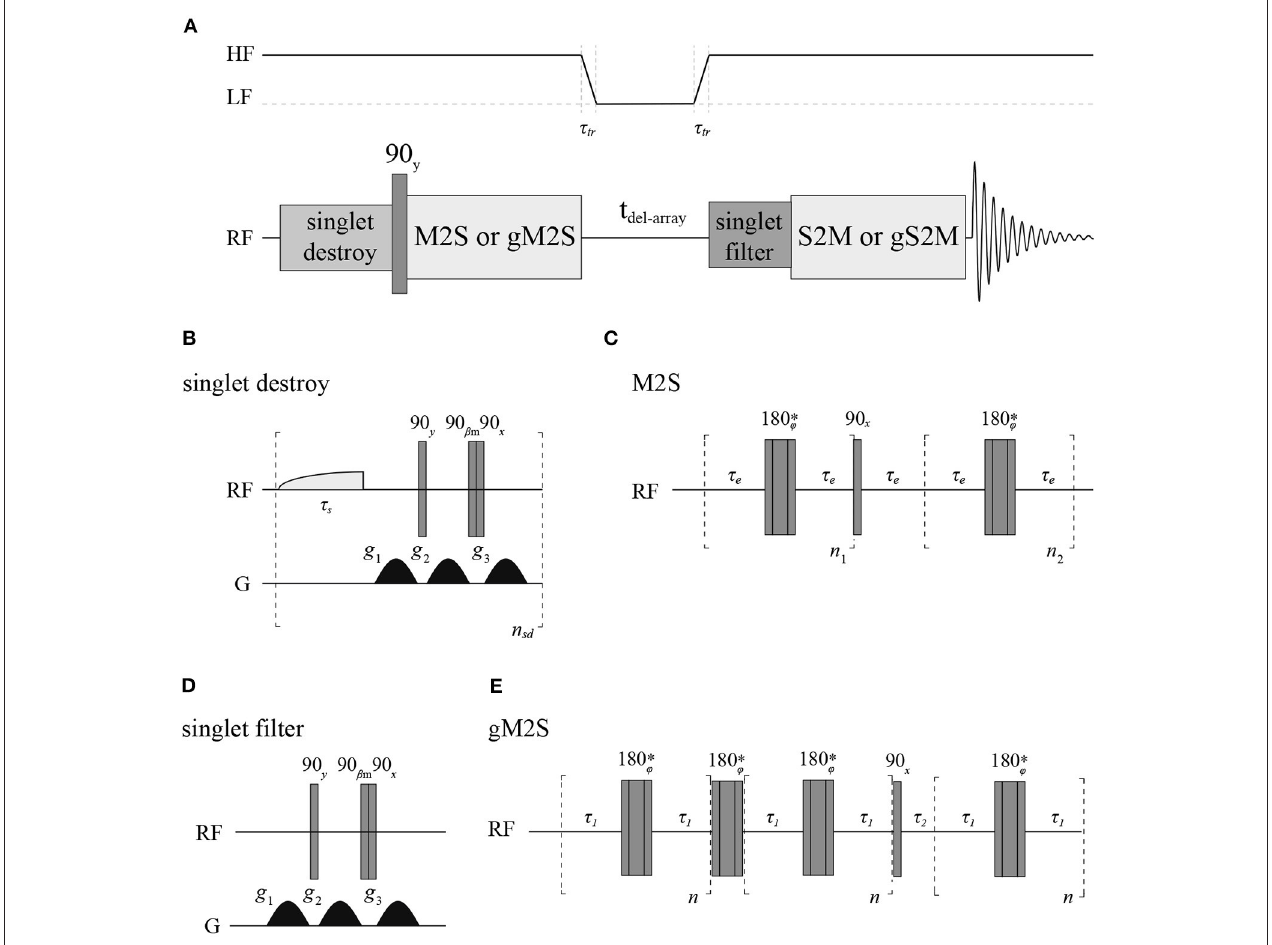
FIGURE 4 | (A) Pulse sequence used to measure T S with details of the singlet-destroy scheme (B) , M2S (C) , T 00 -filter (D), and gM2S (E) blocks. The S2M and gS2M blocks are the time-reverse of M2S and gS2M, respectively. The asterisk indicates a composite 180 ◦ pulse built as 90x180y90x. The phase φ is cycled as [x,x,-x,-x,-x,x,x,- x,-x,-x,x,x,x,-x,-x,x] within the train of 180 ◦ pulses. All gradients have half-sinusoidal shape and β m = arctan(2 1 / 2 ) . The field variation indicated at the top of A is only used during the experiments run in field-cycling mode.